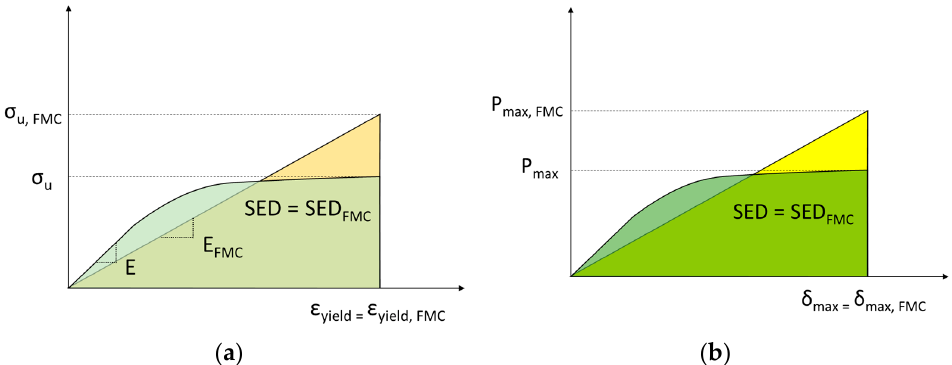
Figure 3. Real material and FMC material; ( a ) Tensile stress-strain curves; ( b ) Load-displacement curves of pre-cracked samples in fracture tests.